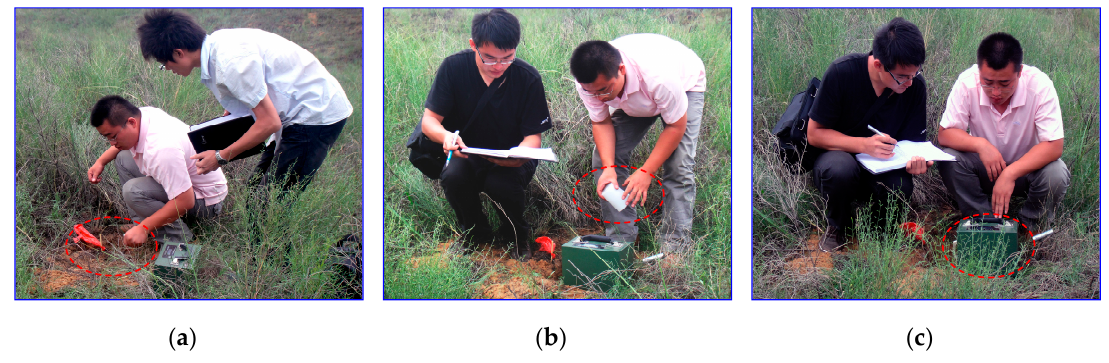
Figure 5. On-site measurement procedures: ( a ) digging a pit; ( b ) embedding a radon collector; ( c ) pulse counting.